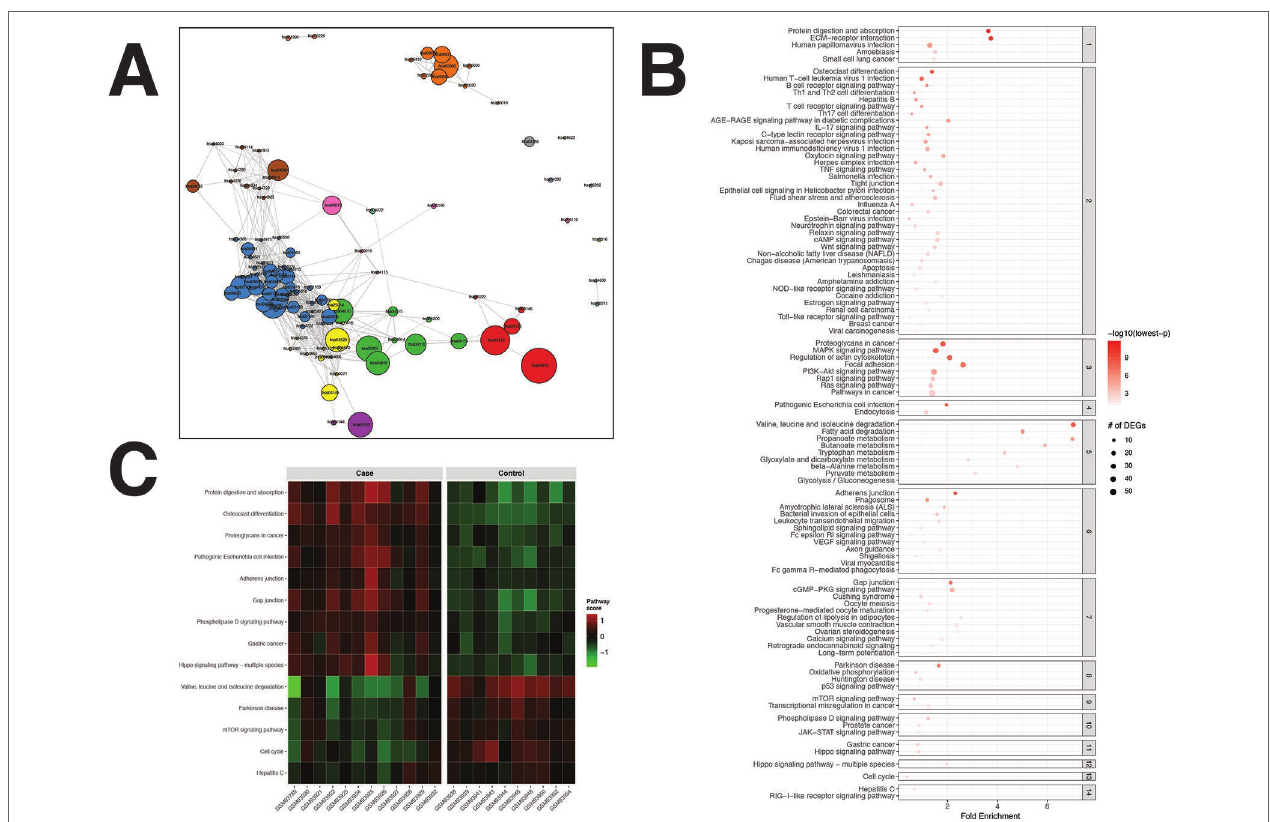
FIGURE 3 | pathfindR enrichment and clustering results on the colorectal cancer (CRC) dataset (lowest p ≤ 0.05). (A) Clustering graph, each color displaying the clusters obtained for CRC. Each node is an enriched pathway. The size of a node corresponds to its −log(lowest_p). The thickness of the edges between nodes corresponds to the kappa statistic between the two terms. (B) Bubble chart of enrichment results grouped by clusters (labeled on the right-hand side of each panel). The x axis corresponds to fold enrichment values, while the y axis indicates the enriched pathways. The size of the bubble indicates the number of differentially expressed genes (DEGs) in the given pathway. The color indicates the −log10(lowest-p) value; the more it shifts to red, the more significantly the pathway is enriched. (C) Heat map of pathway scores per subject. The x axis indicates subjects, whereas the y axis indicates representative pathways. Color scale for the pathway score is provided in the right-hand